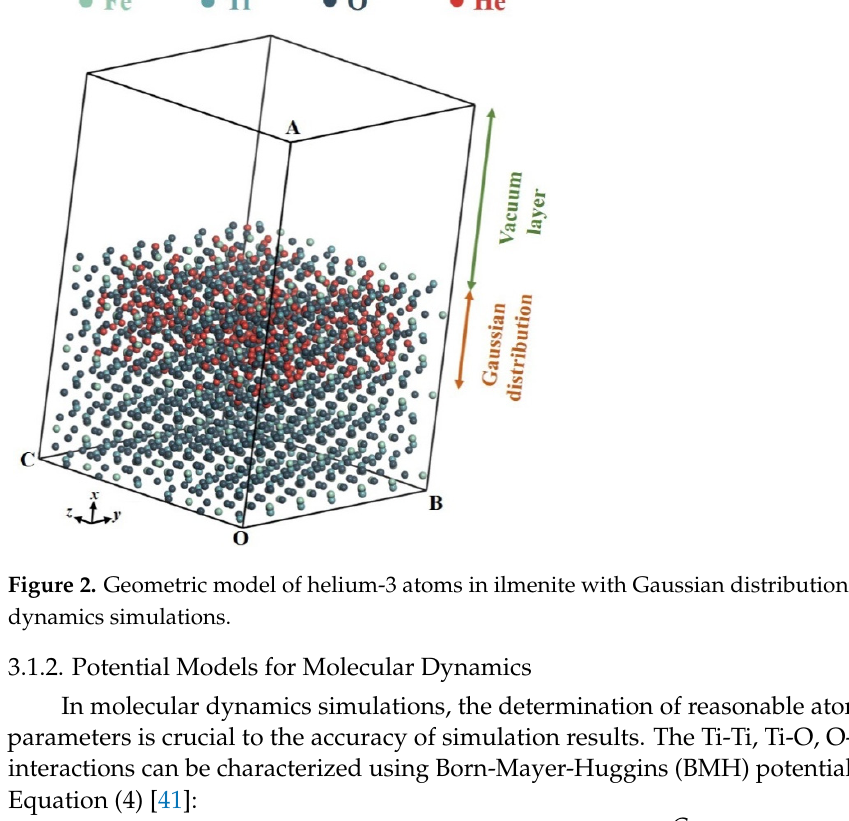
Figure 1. Concentration profile of implanted helium-3 ions in lunar ilmenite. The inset shows a snapshot of the implantation of helium-3 ions into ilmenite.